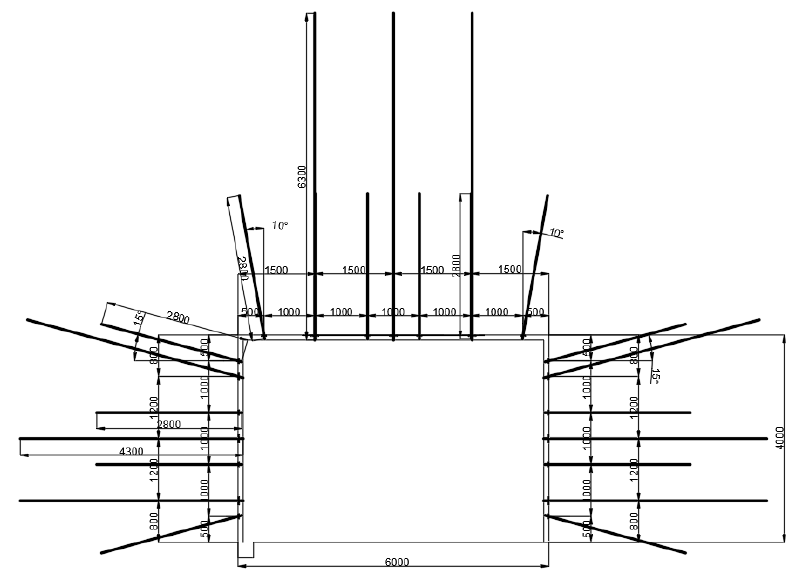
Figure 8. Roadway support design.